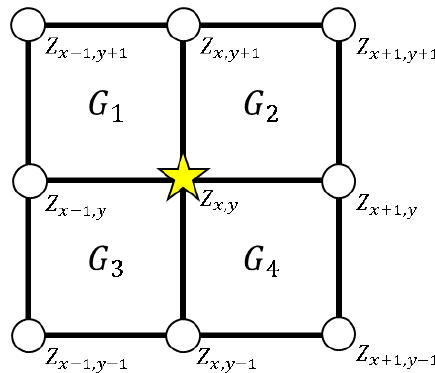
Figure 2. 3-by-3 Kernel over the DEM and its enclosed surface reflectance (i.e. G 1 to G 4